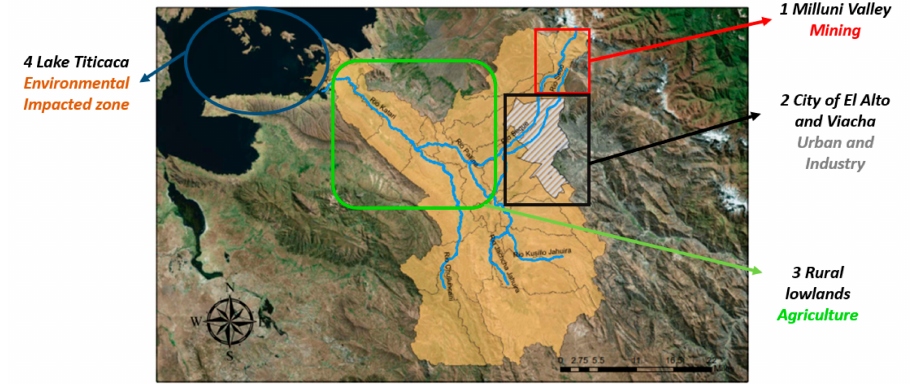
Figure 2. Katari River Basin/sub-regions of